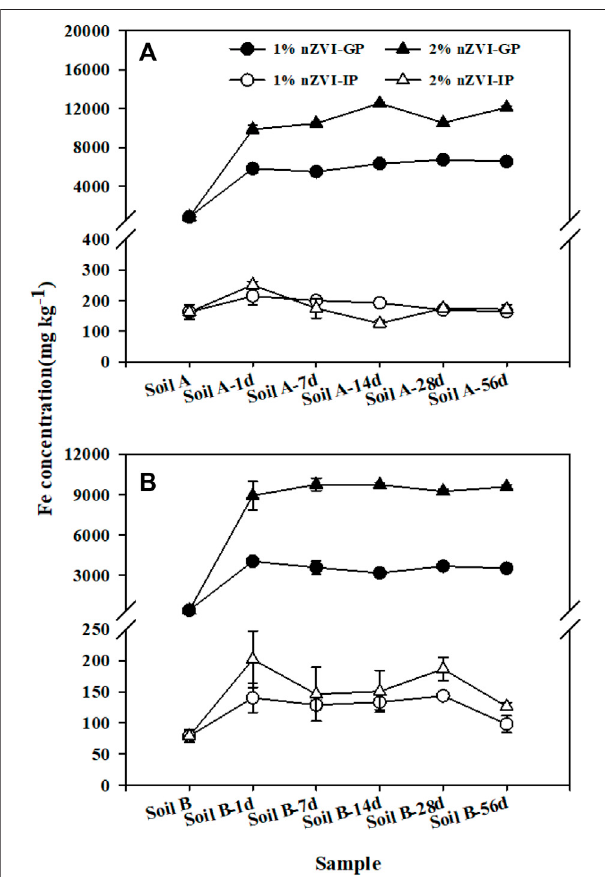
FIGURE 3 | Fe concentration extracted from nZVI untreated and treated soil A (A) and B (B) during the gastric phase (GP) and intestinal phase (IP) of the SBRC assay. Data are expressed as mean and standard deviation of